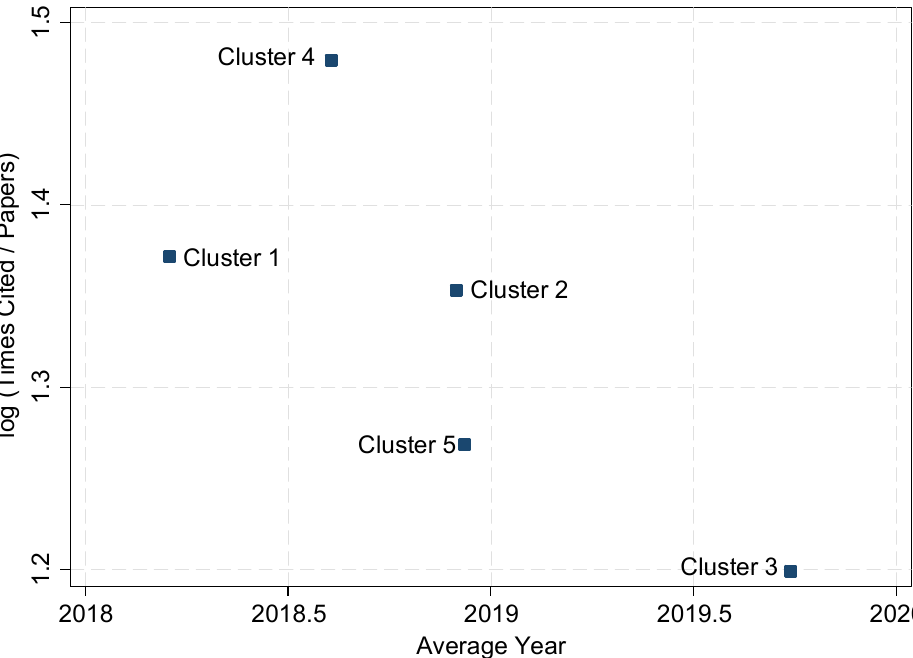
Figure 9. Longitudinal analysis of the most significant clusters.